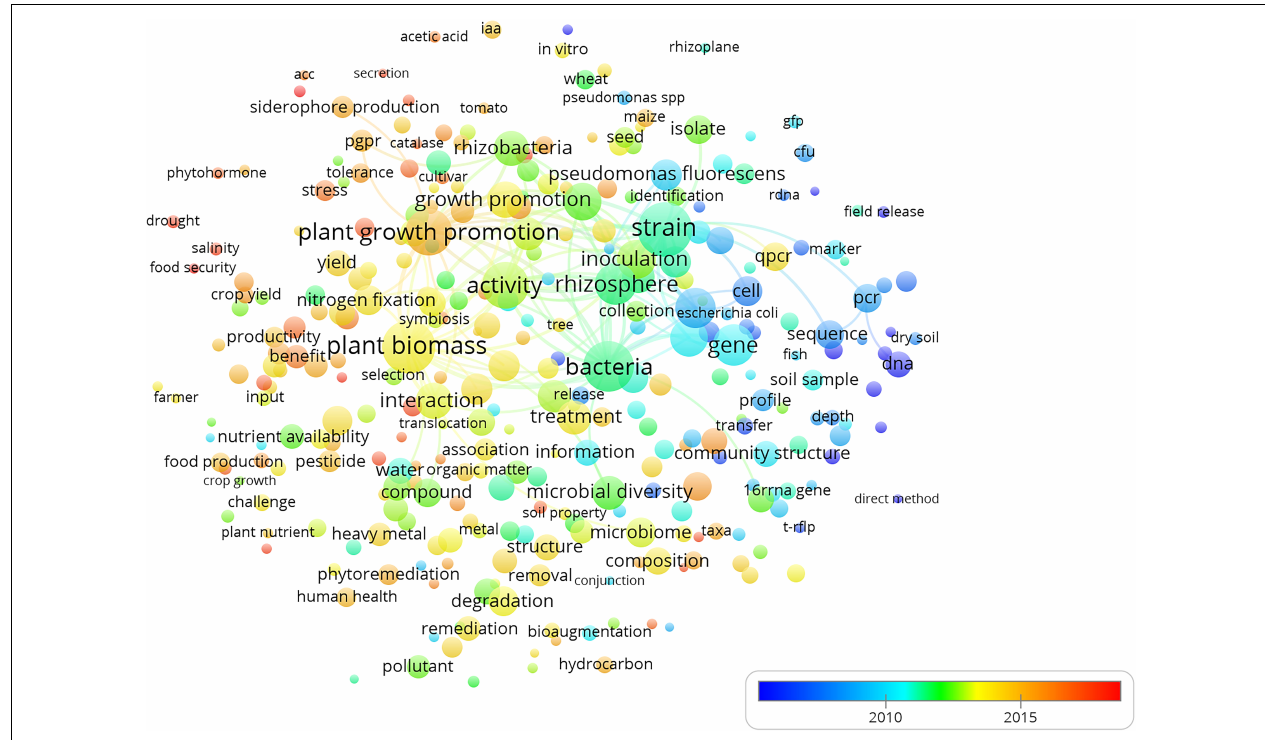
FIGURE 4 | Term map created according to publication year on soil microbial inoculant detection and monitoring based on the Scopus database. The time scale is represented by different colors. The dot size of each term is based on the number of its occurrence. The connecting lines indicate the 100 strongest co-occurrence links between